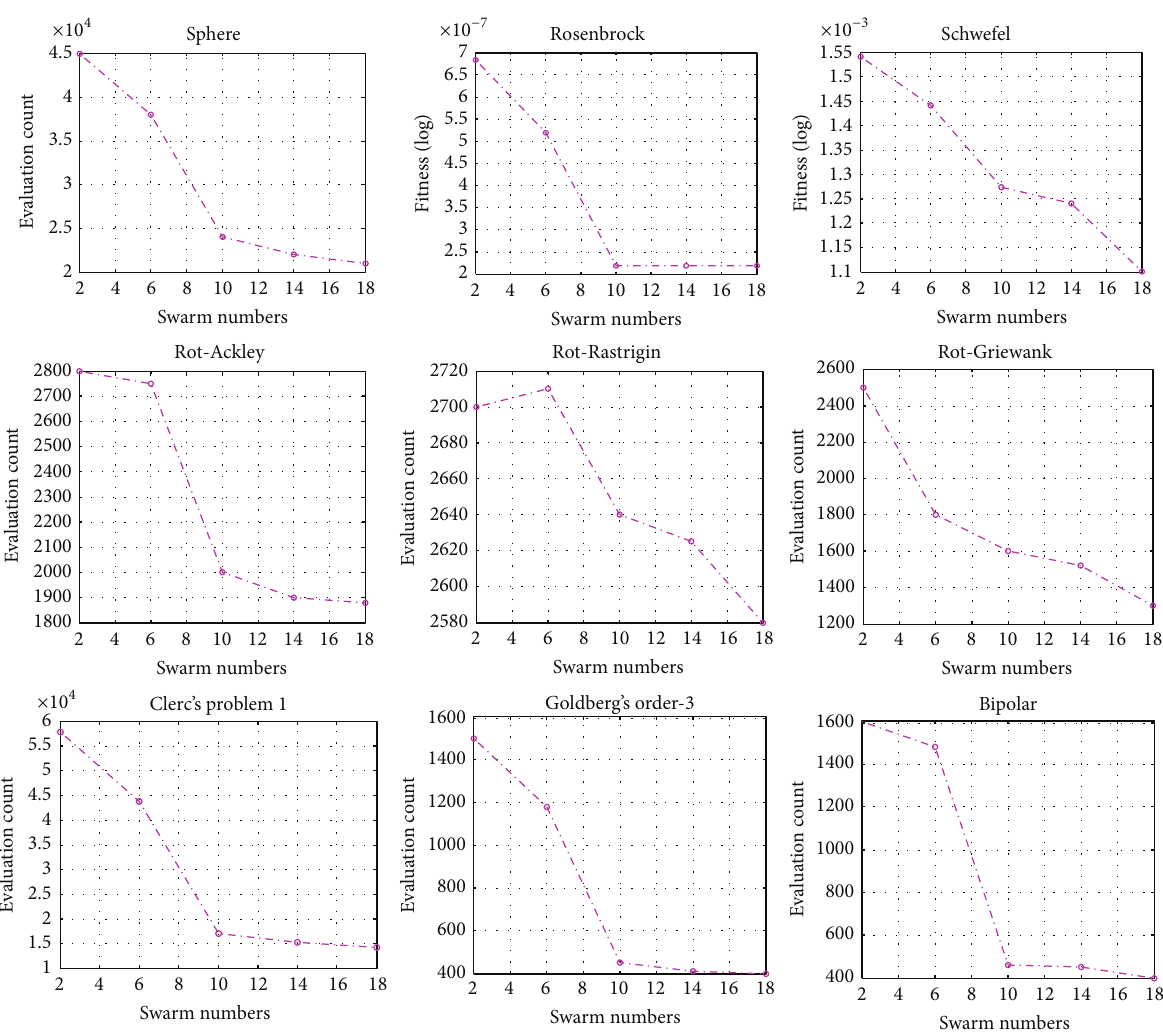
Figure 4: HABC’s results on nine-test functions with different species numbers 𝑁